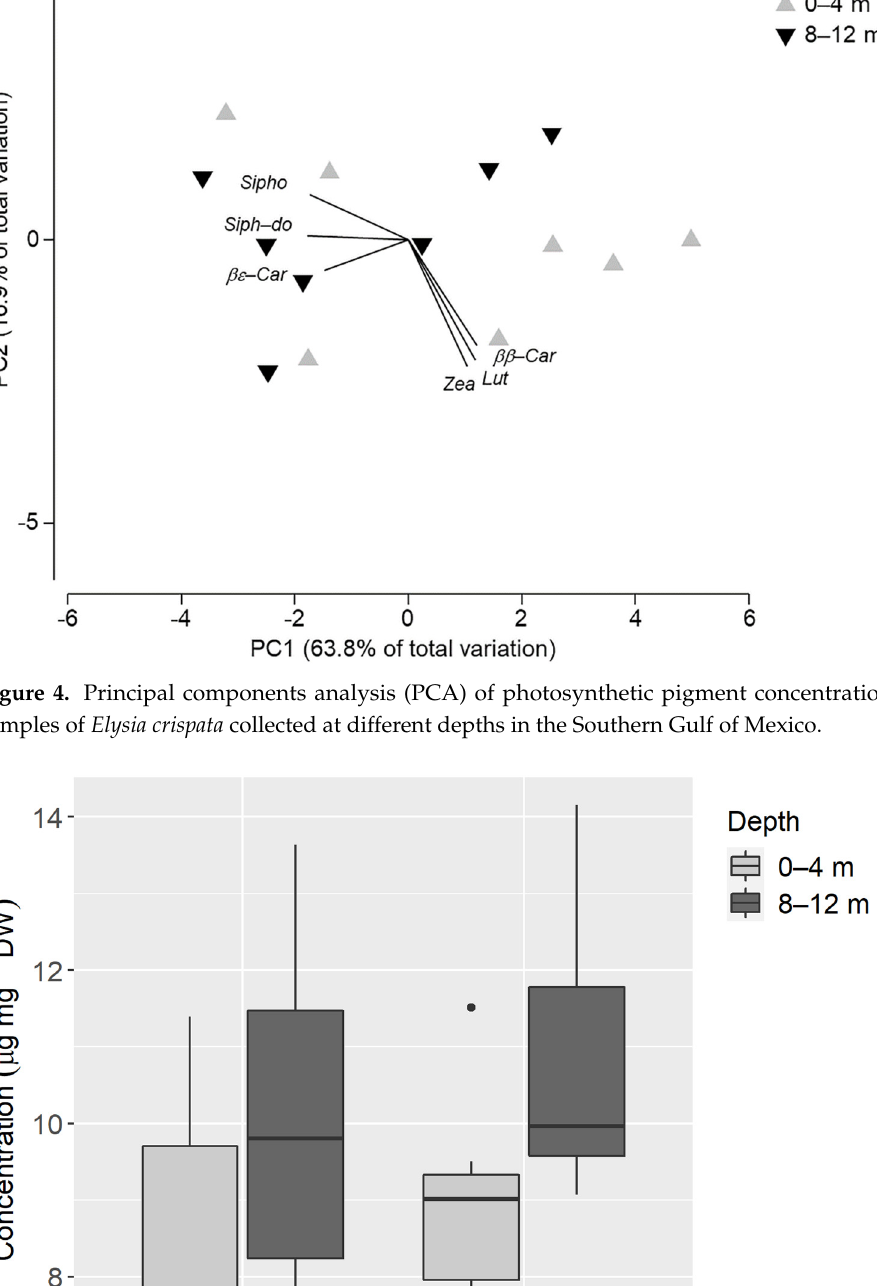
Figure 3. Concentration of photosynthetic pigments from samples of Elysia crispata collected at 0–4 m ( n = 7) and 8–12 m ( n = 7) depth, in the Southern Gulf of Mexico. The line represents the median, top and bottom of the box are the 25th and 75th percentiles. The whiskers represent the maximum and minimum values, and dots are outliers. See Table 1 for full names and respective abbreviations of pigments.